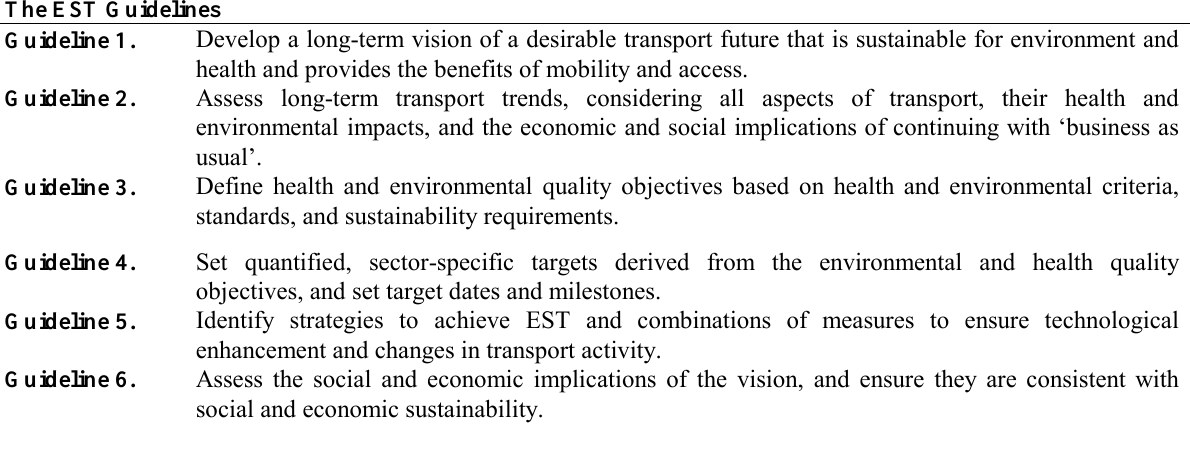
Table 2: The Guidelines on Environmentally Sustainable Transport The EST